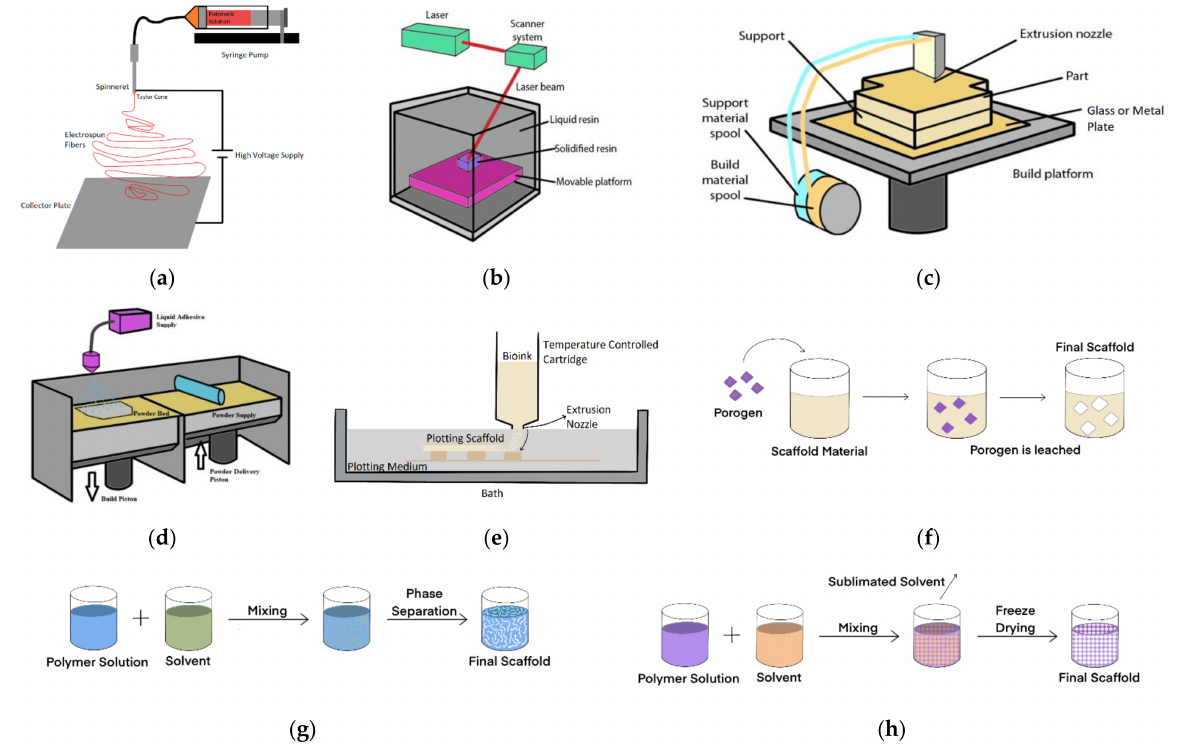
Figure 2. This figure includes schemes of each manufacturing technique manufacturing process. ( a ) Electrospinning Scheme—Section 4.1; ( b ) stereolithography or SLA scheme—Section 4.2.1; ( c ) fused deposition modelling or FDM scheme— Section 4.2.2; ( d ) selective laser sintering or SLS scheme—Section 4.2.3; ( e ) bioplotting scheme—Section 4.2.4; ( f ) salt